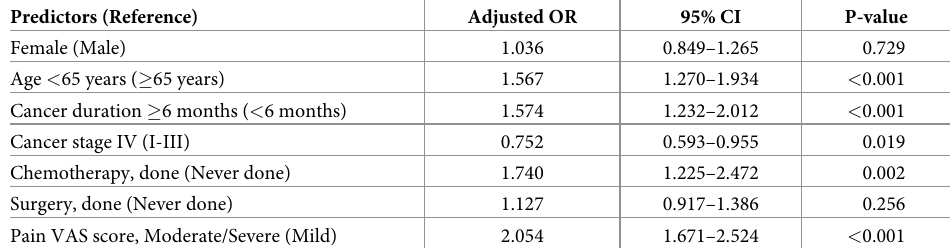
Table 2. Clinical predictors of patients with NCP (N = 2,003).